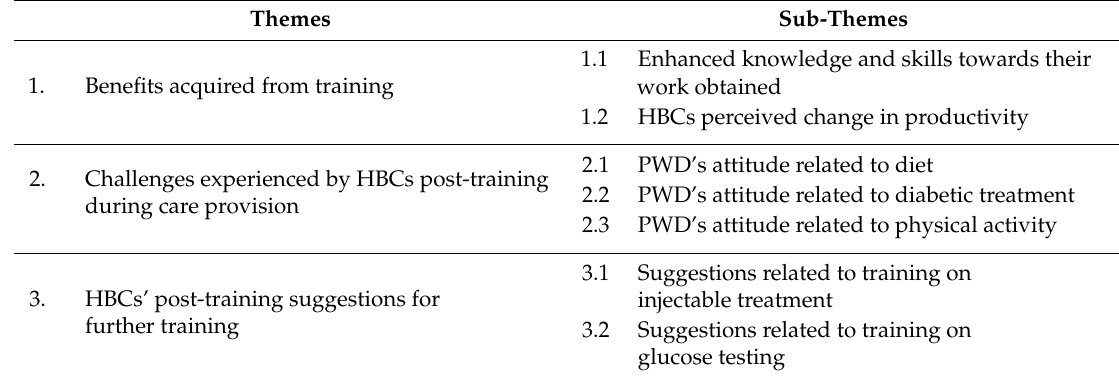
Table 5. Themes and sub-themes reflecting behavior and results levels of the home-based carers (HBCs)